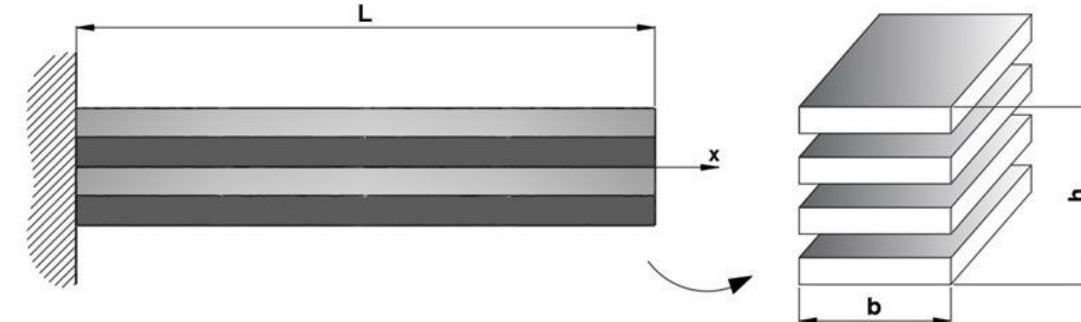
Figure 3. Clamped-Free (CF) laminated composite beam problem model.